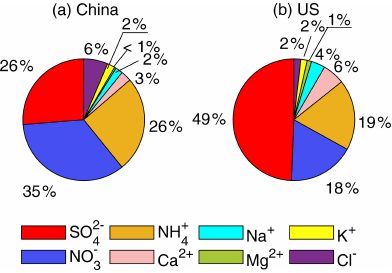
Figure 5. Annual average values of water-soluble ions (WSIs) con- centration profiles in China (a) and in the United States (b)